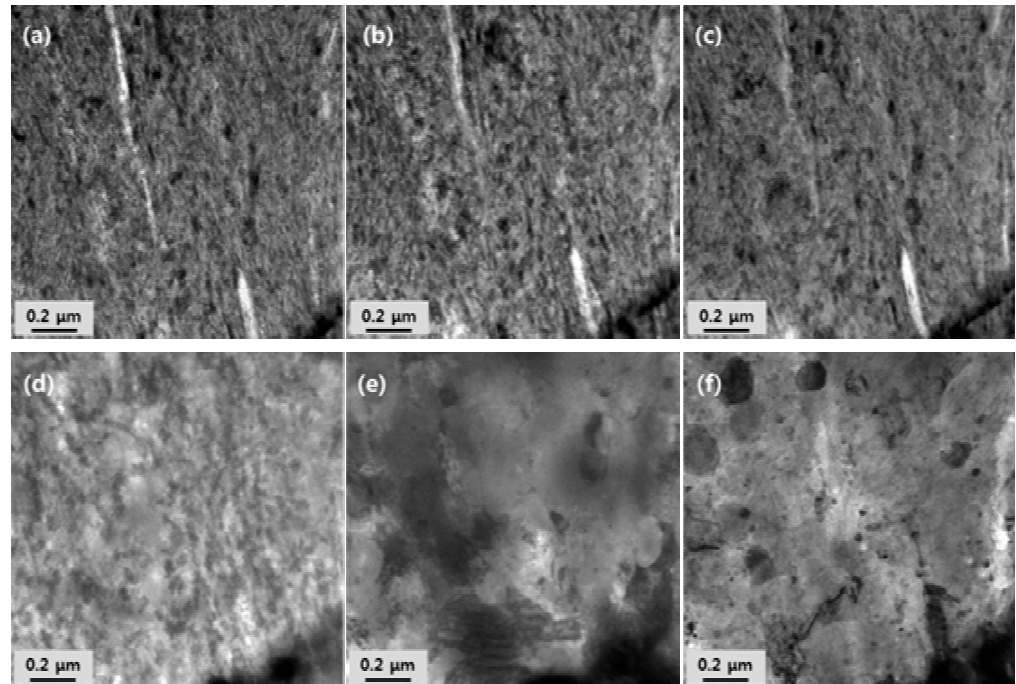
Figure 4. In-situ TEM images of the mechanically alloyed Fe-10Cr-5Y 2 O 3 powders after heating at ( a ) 25 °C, ( b ) 600 °C, ( c ) 700 °C, ( d ) 800 °C, ( e ) 900 °C and ( f ) after cooling from 900 °C to room temperature.